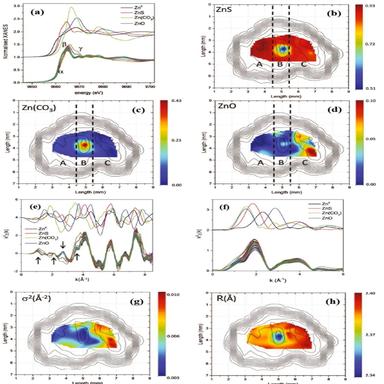
(a) Zn K-edge XANES spectra collected on the sphalerite sample. (b) ZnS, (c) ZnCO3, (d) ZnO fractions spatial distribution as obtained from LCF of standards superimposed to Zn elemental distribution contour plot. (e) Zn K edge EXAFS spectra and (f) relative FT collected on the sphalerite sample together with reference compounds' signals. Spatial distribution of Debye Waller factor (g) and distance (h) superimposed to Zn elemental distribution contour plot.